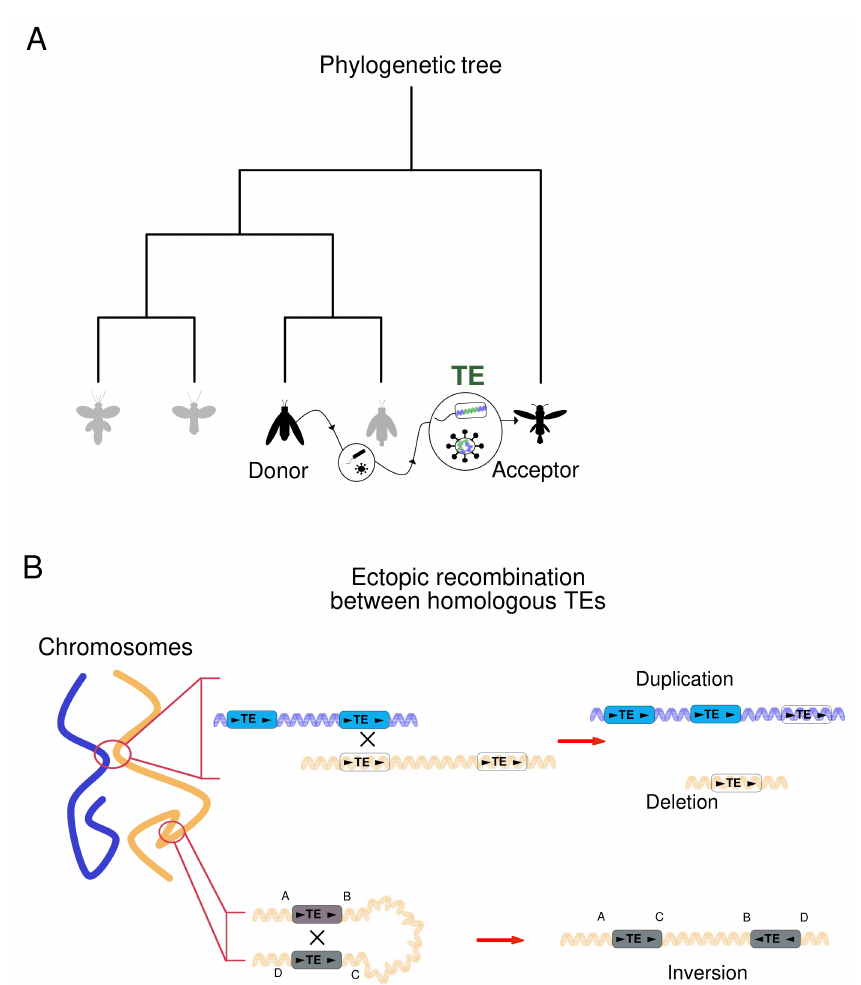
Figure 2. TEs invaded and rewired genomes by Horizontal Transfer and structural variations. Schematic representation of ( A ) a phylogenetic tree highlighting a Horizontal Transposons Transfer between donor and acceptor species. Magnified in circles, putative agents responsible for TEs (green) shuttling, such as bacteria and viruses. ( B ) TEs-mediated ectopic recombination. From left to right: non-homologous chromosomes in close proximity. Ectopic recombination between homologous TEs results in duplication and deletion on the respective chromosomes’ arms. Below, alternative outcome is represented by a genomic inversion mediated by TEs with the structural reconfiguration of the genomic segment affected. Altogether, these dynamic hotspots of DNA recombination contribute to somatic variation, organismal complexity, and diseases